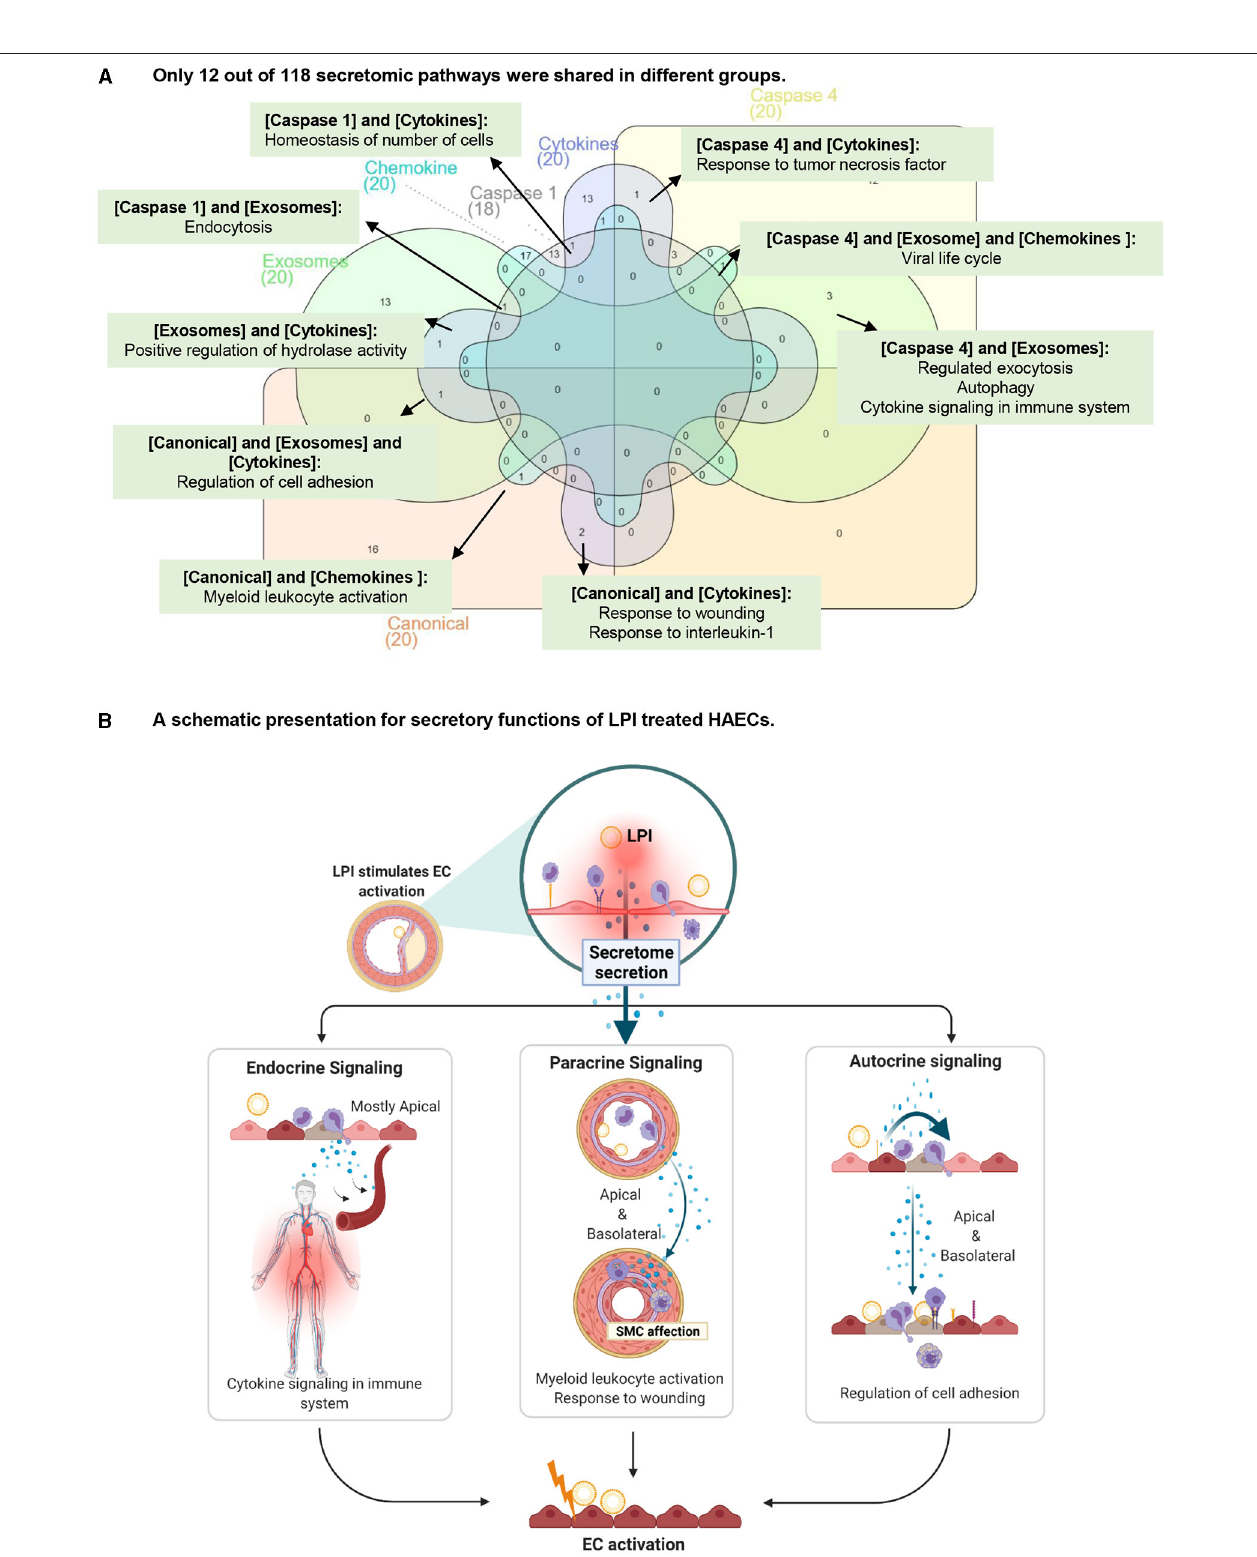
FIGURE 7 | The majority of secretory pathways are mutually exclusive in LPI-stimulated HAECs. (A) Venn diagram was used to check the overlapped pathways among six secretomic groups. * (B) was created with Biorender.com.